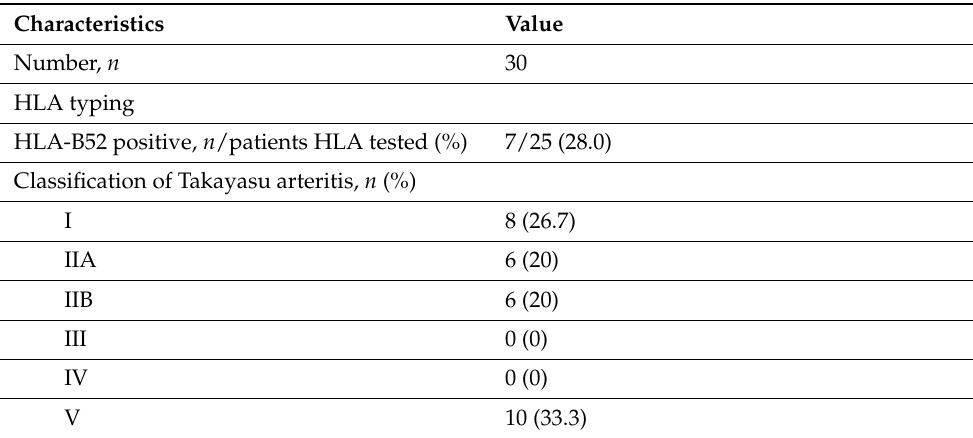
Table 3. Other baseline characteristics of the enrolled TA